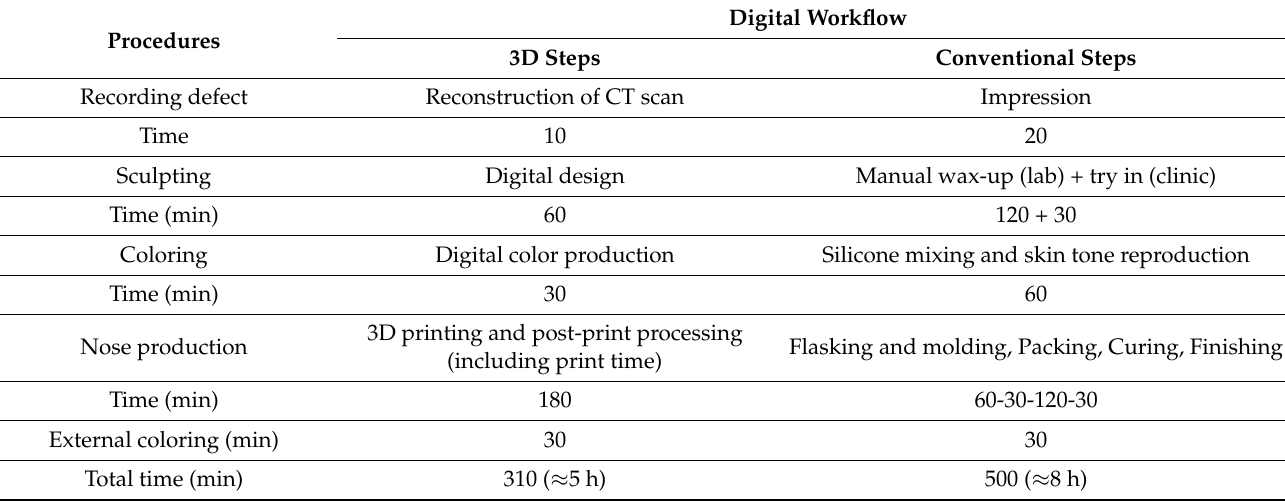
Table 5. Comparison between conventional and 3D workflows to construct a nasal prosthesis [38].